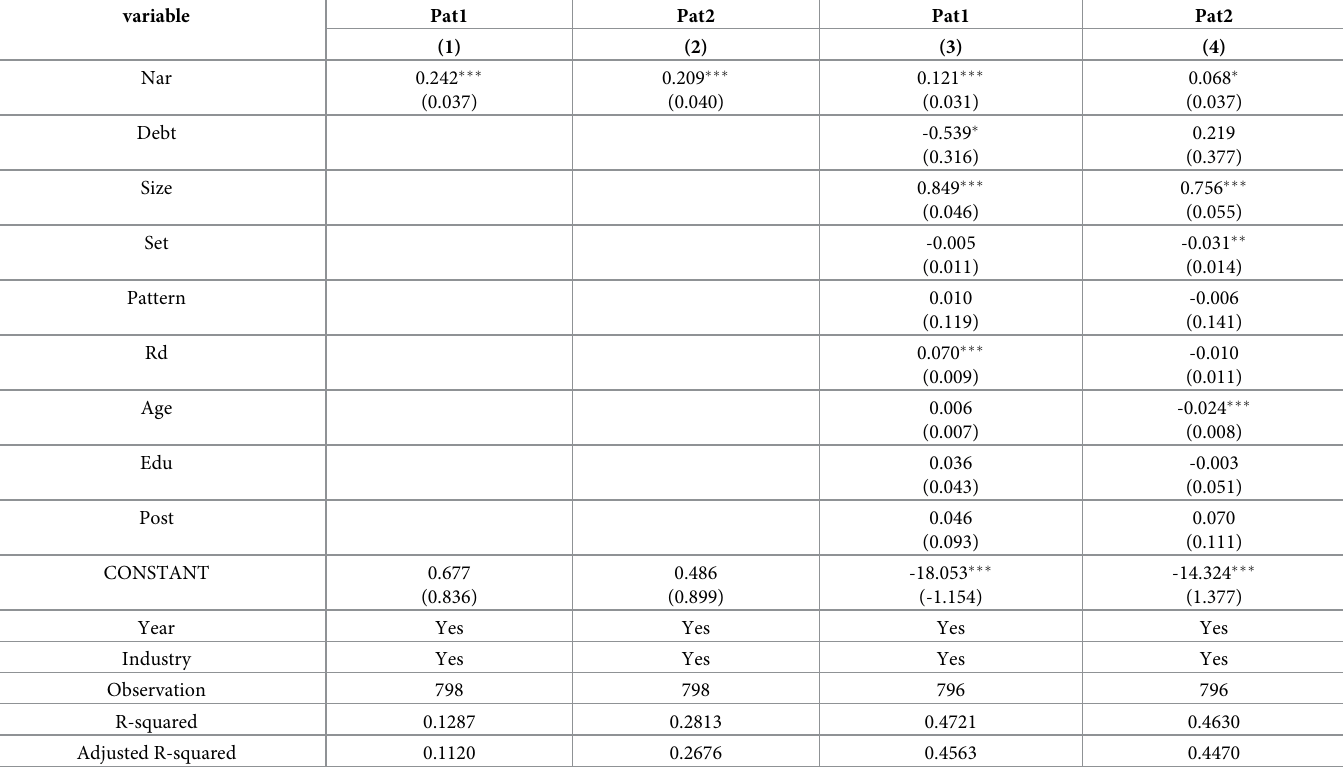
Table 7. Principal component factor analysis—benchmark regression robustness